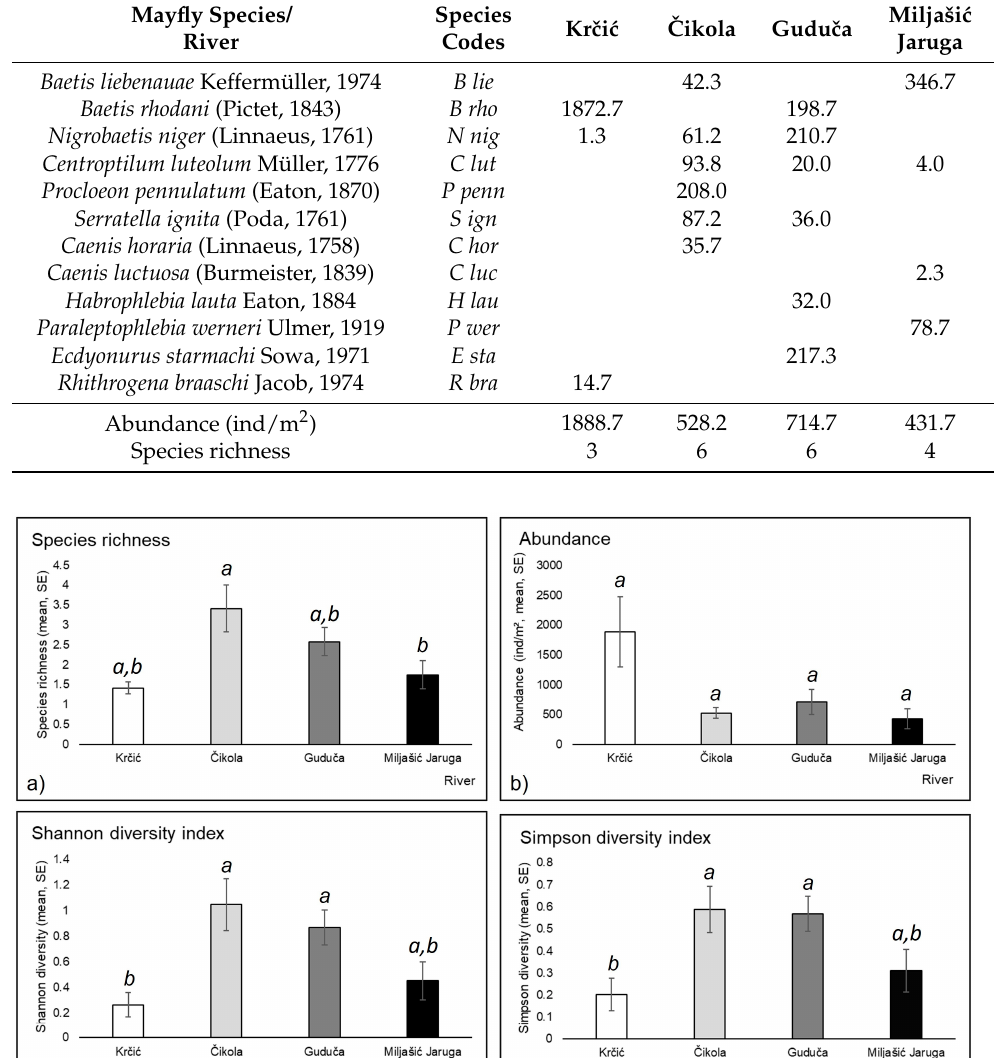
Table 1. Mayfly species and their abundance (number of individuals per m 2 ) recorded at four intermittent rivers in the karst Mediterranean region of the Balkans, Croatia. Species codes are used in the CCA.